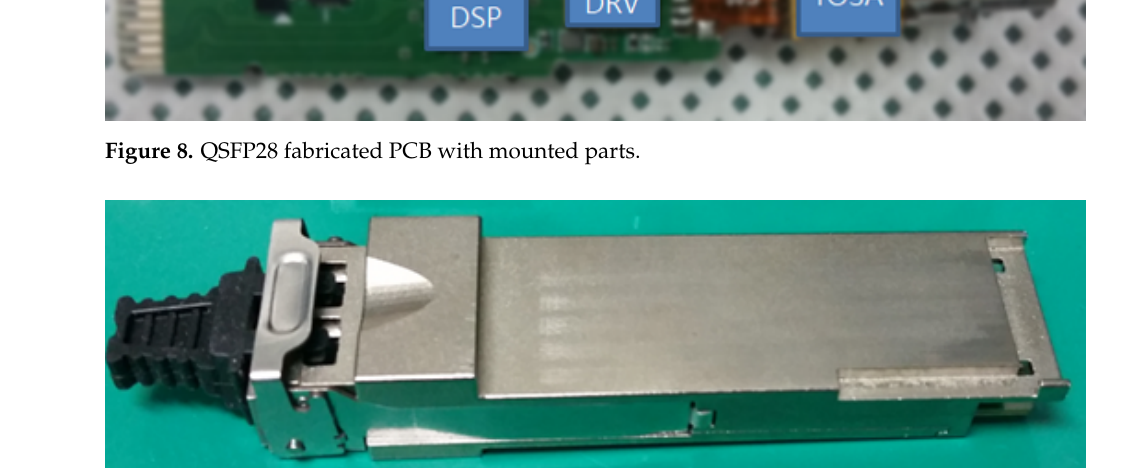
Figure 9. QSFP28 optical transceiver case